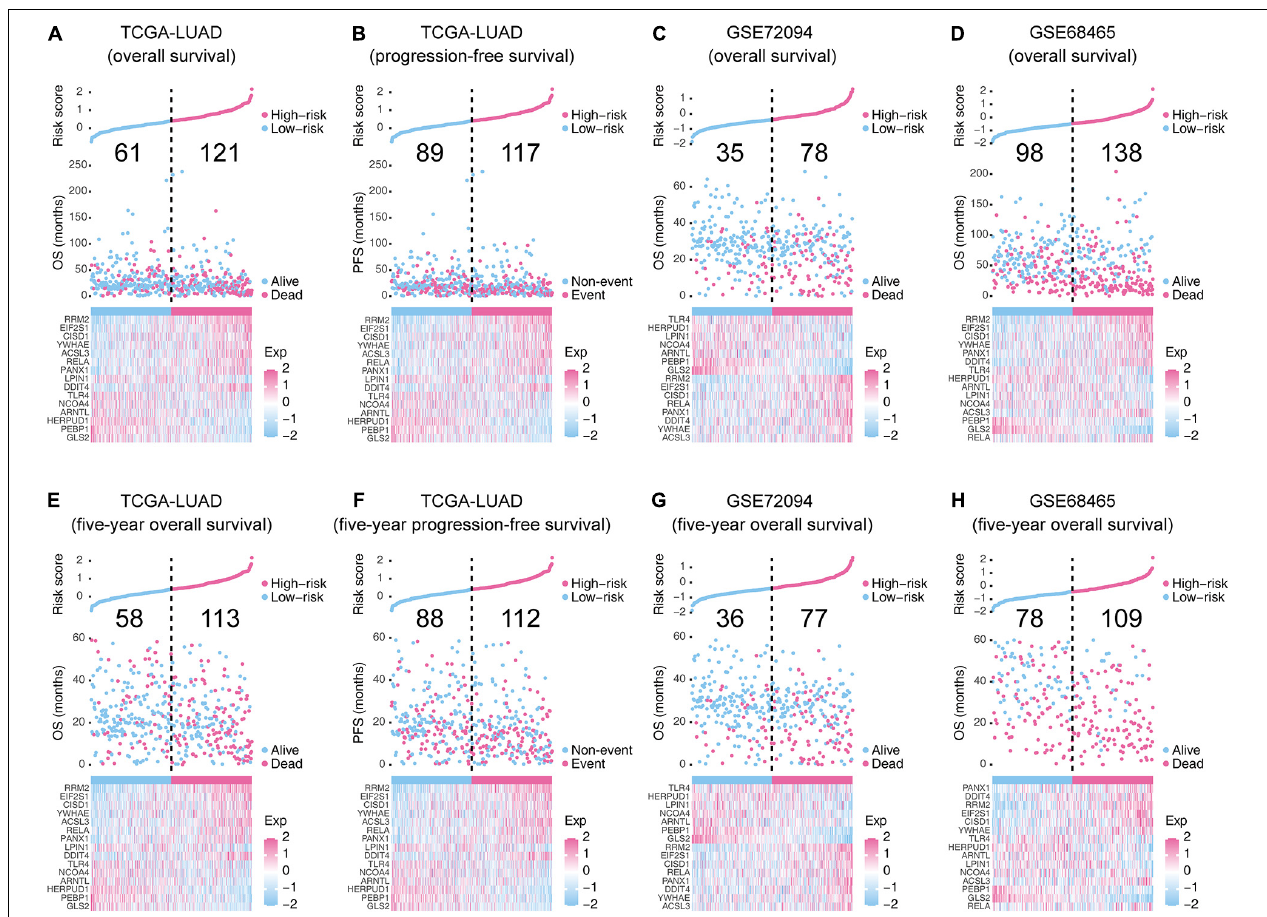
FIGURE 3 | The overall performance of the 15-gene signature in the training and validation cohorts. (A,C–E,G,H) The upper parts indicate the distributions of risk score, and the middle parts indicate the patients’ survival status and survival time. (B,F) The upper parts indicate the distributions of risk score, and the middle parts indicate the patients’ event status and event time. The bold numbers in the middle-upper part of each graph represent the death/event counts in the low-risk and high-risk groups. The bottom part of each graph shows the heatmap of 15 gene expression profiles. Exp, expression